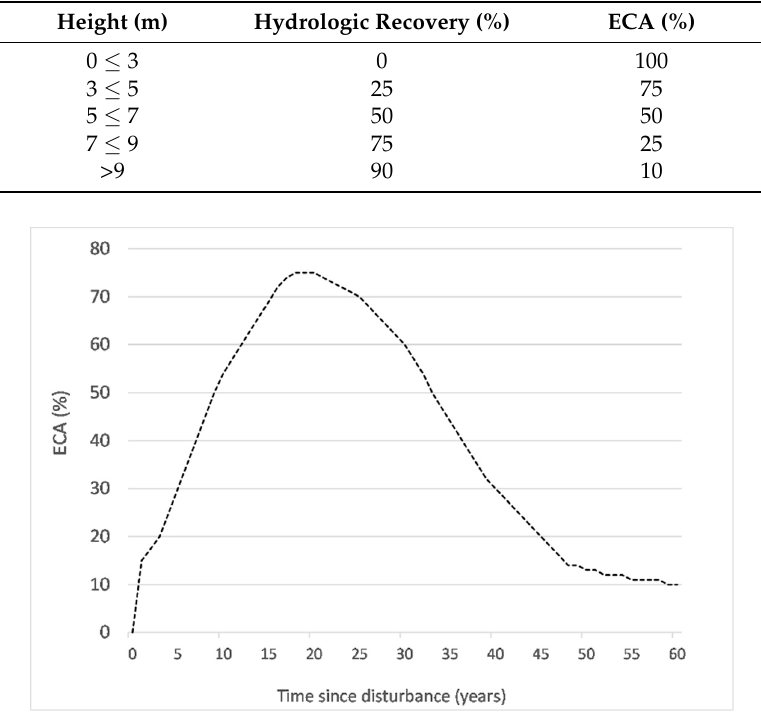
Figure 2. Equivalent clear-cut area (ECA) (%) since year of disturbance by mountain pine beetle (MPB).